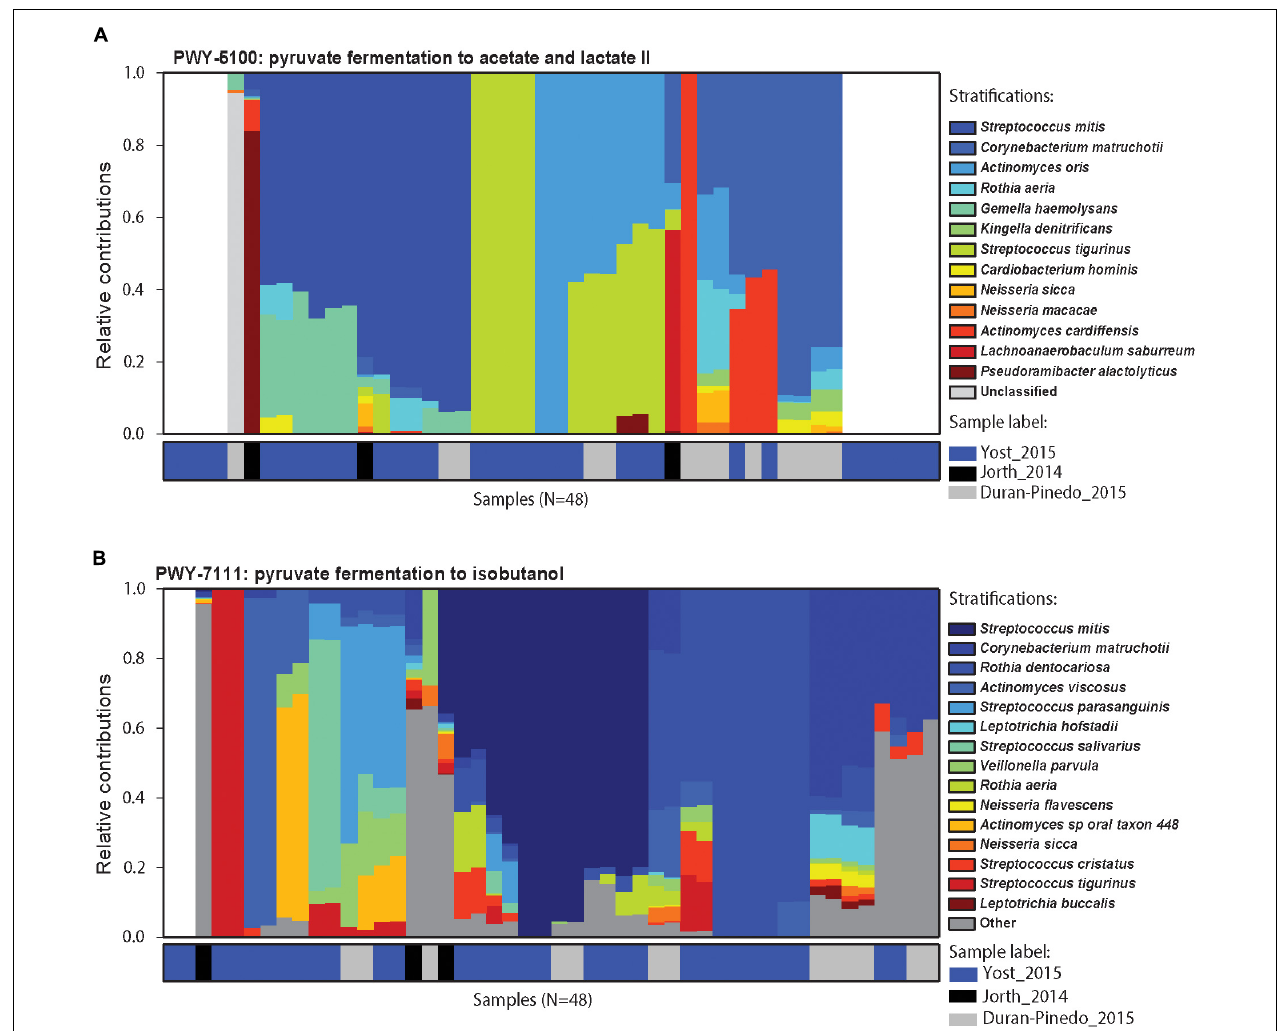
FIGURE 5 | Contributors to pyruvate metabolism during disease. Relative contributions of different bacteria in the two pyruvate metabolism pathways in different samples. (A) Relative contributions of various organisms in the fermentation of pyruvate to acetate and lactate in each disease sample. Top 15 contributing organisms are listed by name and the rest are grouped as others. Columns are annotated by the study they come from. Different organisms perform similar functions in different disease samples maintaining the functional signature despite the community composition. (B) Relative contribution of various organisms in the fermentation of pyruvate to isobutanol. Again, functional signature is maintained despite differences in the organisms carrying out fermentation in the different